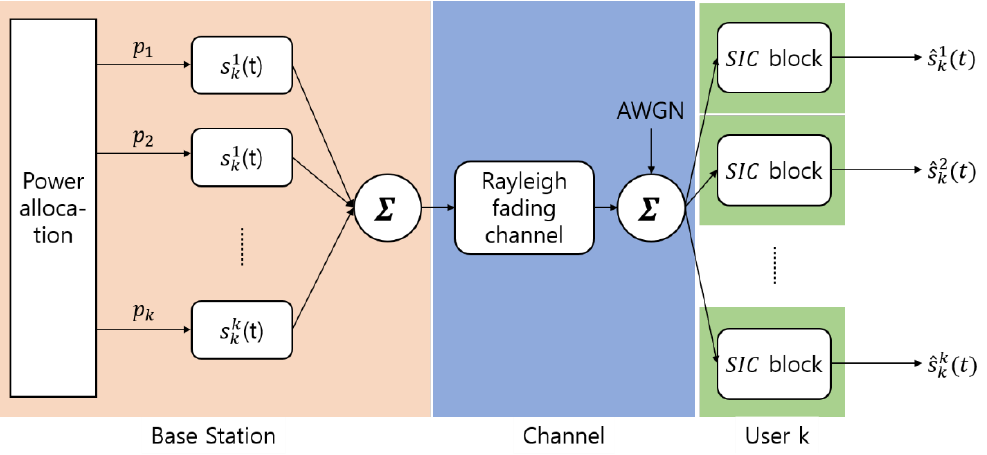
Figure 1. Proposed nonorthogonal multiple access (NOMA) system architecture.